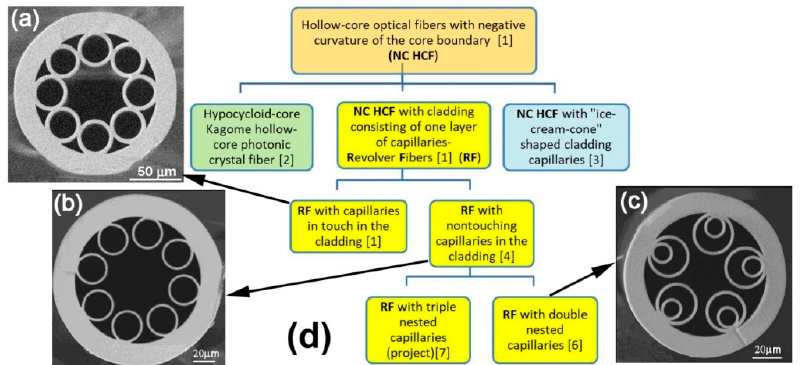
Figure 1. Cross section images of revolver fibers (RF): ( a ) RF with single touching capillaries in the cladding [1]; ( b ) RF with single non-touching capillaries in the cladding [4]; ( c ) RF with double nested non-touching capillaries [6]; and, ( d ) The family of hollow-core optical fibers with negative curvature of the core boundary [7].